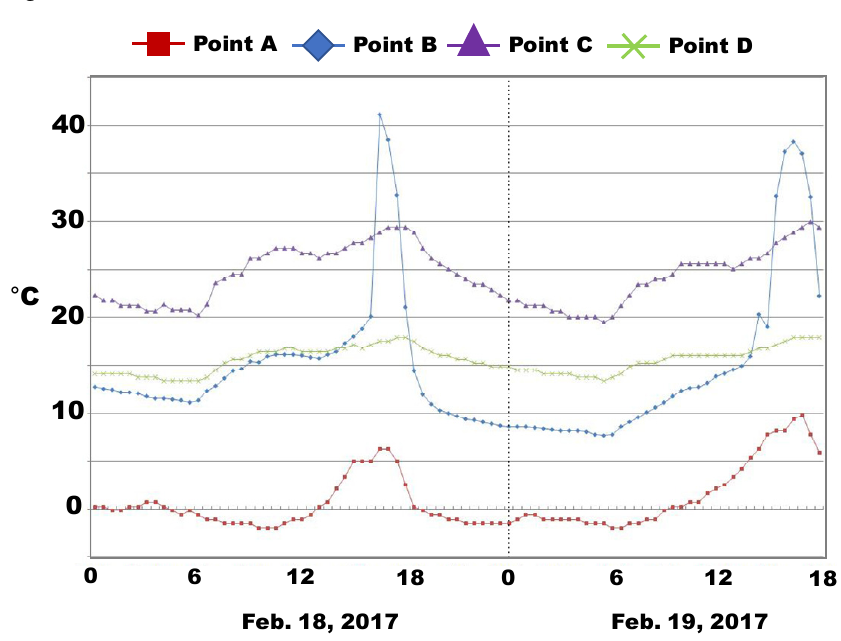
Figure 11. Measurement results at the 10th floor.